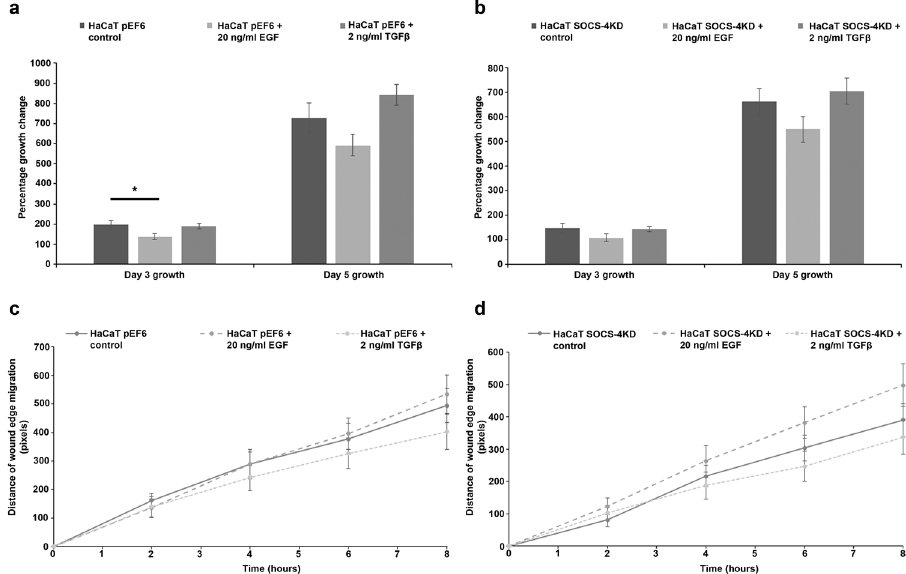
Figure 6. Impact of SOCS-4 suppression on the proliferative and migratory responses of HaCaT keratinocytes to EGF and TGF β . Proliferative rates of ( a ) HaCaT pEF6 and ( b ) HaCaT SOCS-4 knockdown cells in addition to 20 ng/ml EGF or 2 ng/ml TGF β were assessed using a MTT growth assay over 3 and 5 days. Cellular migration in response to 20 ng/ml EGF and 2 ng/ml TGF β was also explored using a conventional scratch wound assay on ( c ) HaCaT pEF6 and ( d ) HaCaT SOCS-4 knockdown cells. Data shown are mean values of a minimum of three independent repeats, error bars represent the standard error of the mean and * represents p <